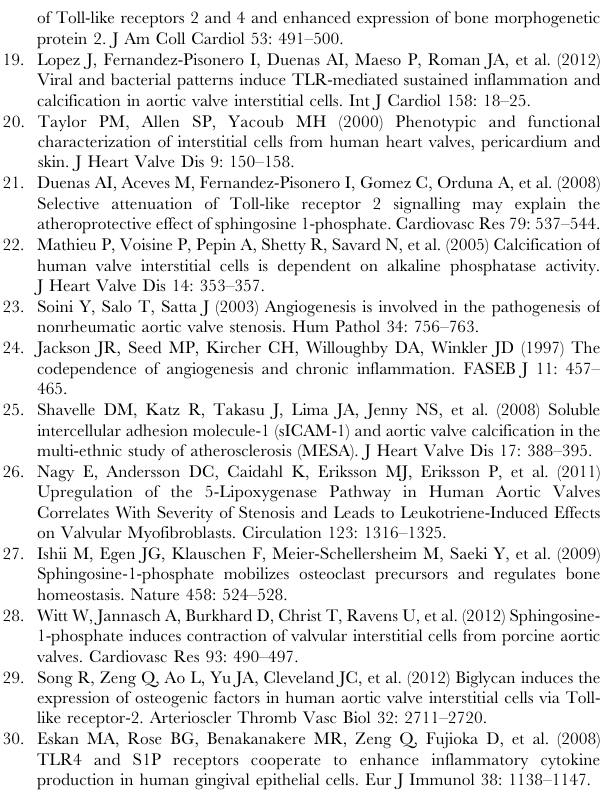
Figure S1 Characterization of AVICs from stenotic and control aortic valves and PVIC from control pulmonary valves. Cells were labeled with a FITC-conjugated antibody against a -SM-actin followed by DAPI staining to visualize nuclei, and later analyzed by fluorescence microcopy (Nikon ECLIPSE 90i fluorescence microscope coupled to a Nikon DS-Ri1 camera). Representative images of cells correspond to stenotic (left panel) and control aortic valve cells (central panel), and to control pulmonary valve cells (right panel), being control AVIC and control PVIC isolated from the same patient. Images were obtained using Image J software. In green are shown images from